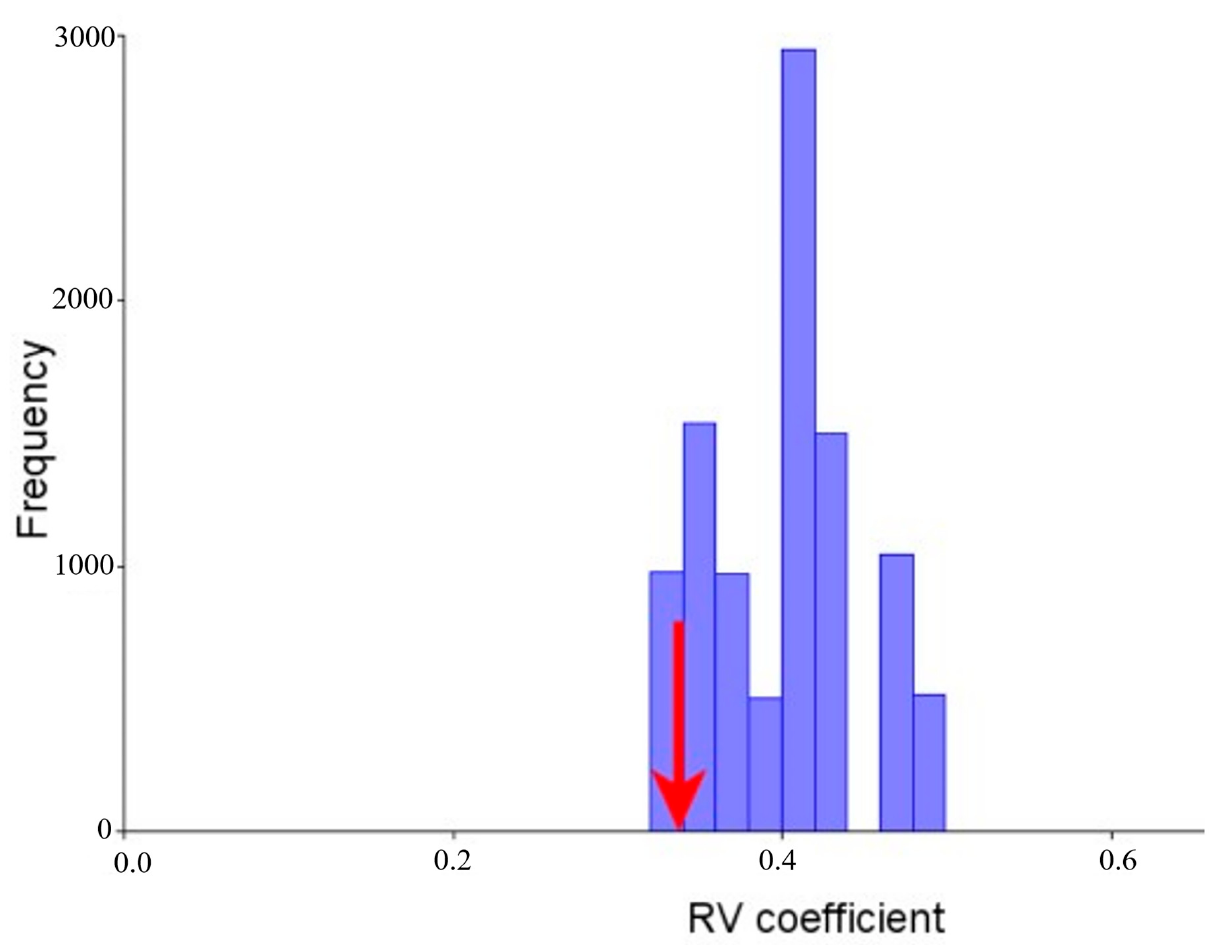
Figure 3. Histogram of the distribution of 291 RV coefficients generated by permutation. The arrow shows that our hypothesis is at the extreme left of the distribution curve, being the partition with the lowest RV coefficient (RV = 0.337080; percentage of alternative partitions with an RV value lower than that of the hypothetical modules: 2.91%; 1000 rounds of permutation).